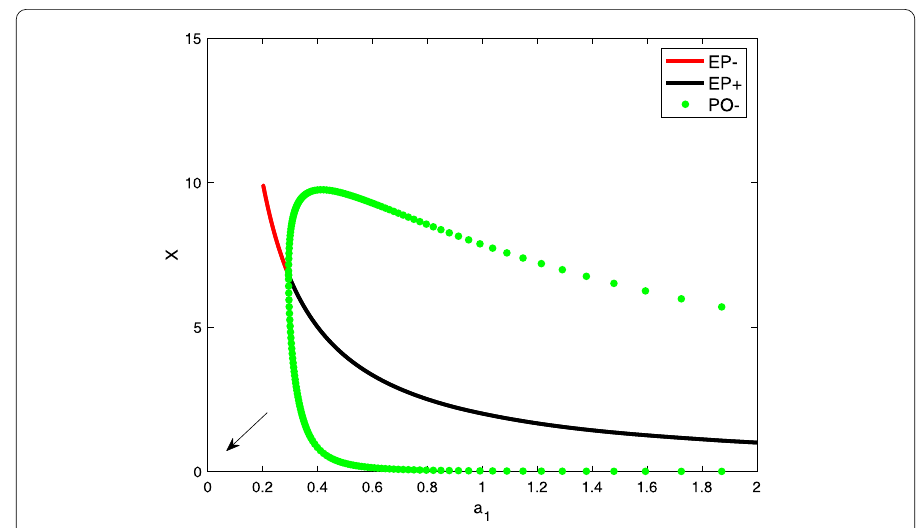
Figure 1 A bifurcation diagram showing X as a function of a 1 . Parameter values are a 1 = 0.3, a 2 = 0.6, a 3 = 4, a 4 = 10, and (cid:5) = 0.05